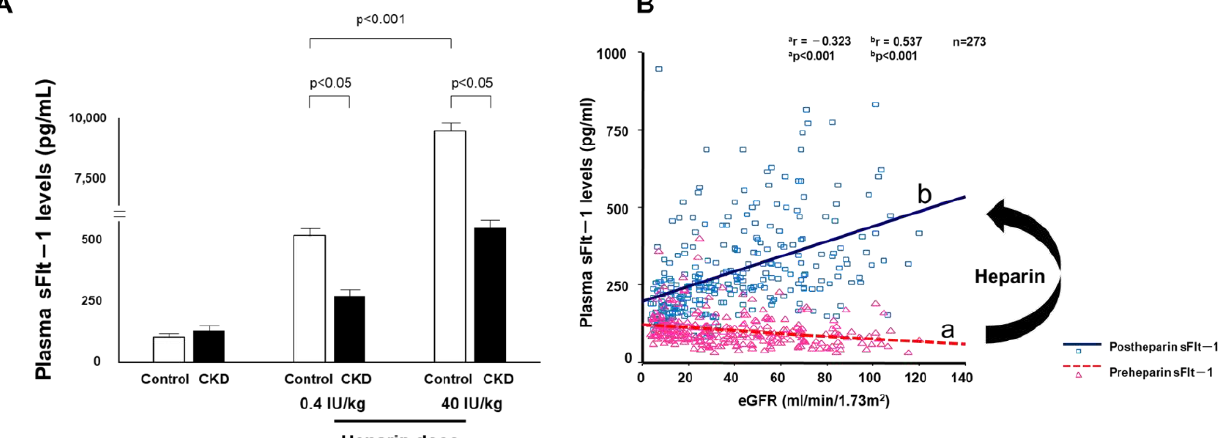
Figure 3. Elevated sFlt-1 with heparin treatment ( A ) Heparin reverses the relationship between sFlt-1 and eGFR. The heparin loading test shows low levels of sFlt-1 in CKD patients compared with those in control subjects at 5 min after heparin infusion. ( B ) Pre- and post-heparin sFlt-1 levels are negatively and positively correlated with eGFR, respectively.